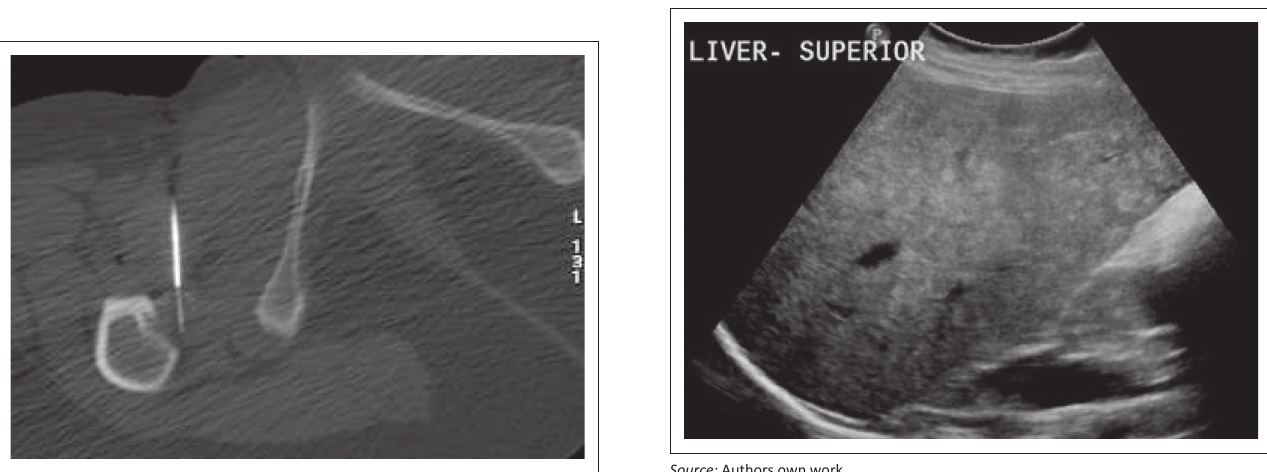
Source: Authors own work FIGURE 7: Axial CT image acquired in biopsy